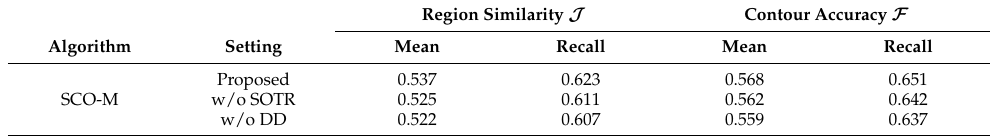
Table 5. Performances on the validation set in DAVIS2017 according to the feature settings. The per- formance of the proposed setting is boldfaced.